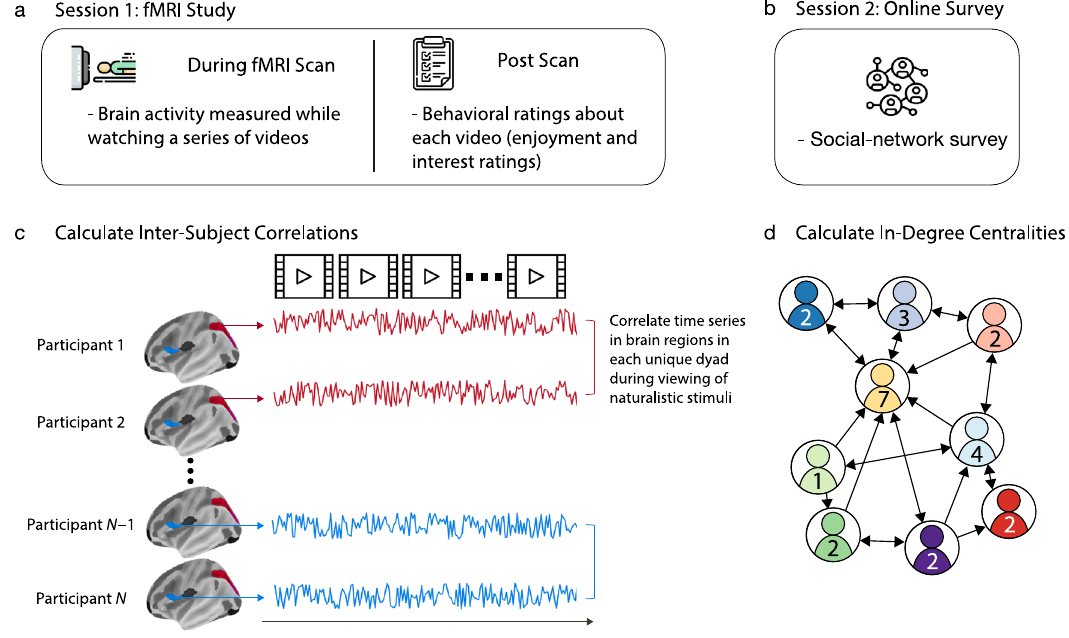
Fig. 1 Study paradigm and calculations. a Schematic of the fMRI study paradigm. In session 1 of the study, participants attended an in-lab session in which their brain activity was measured using fMRI while they watched a series of naturalistic stimuli (i.e., videos). After the fMRI scan, the participants provided ratings on how enjoyable and interesting they found each video. b Schematic of our social-network survey. In session 2 of the study, participants completed an online social-network survey in which they indicated the individuals in their residential community with whom they were friends. c Schematic of neural similarity. We extracted the time series of neural responses that were obtained as participants viewed the stimuli. We then calculated inter-subject correlations (ISCs) of these time series for each of 214 brain regions. d Schematic of our network calculations. Based on the participants ’ responses in ( b ), we constructed two directed, unweighted networks — with one for each residential community — in which each node represents an individual and each directed edge represents one individual nominating another as a friend. For each individual, we calculated in-degree centrality, which counts the number of times that that individual was nominated as a friend by others in their own residential